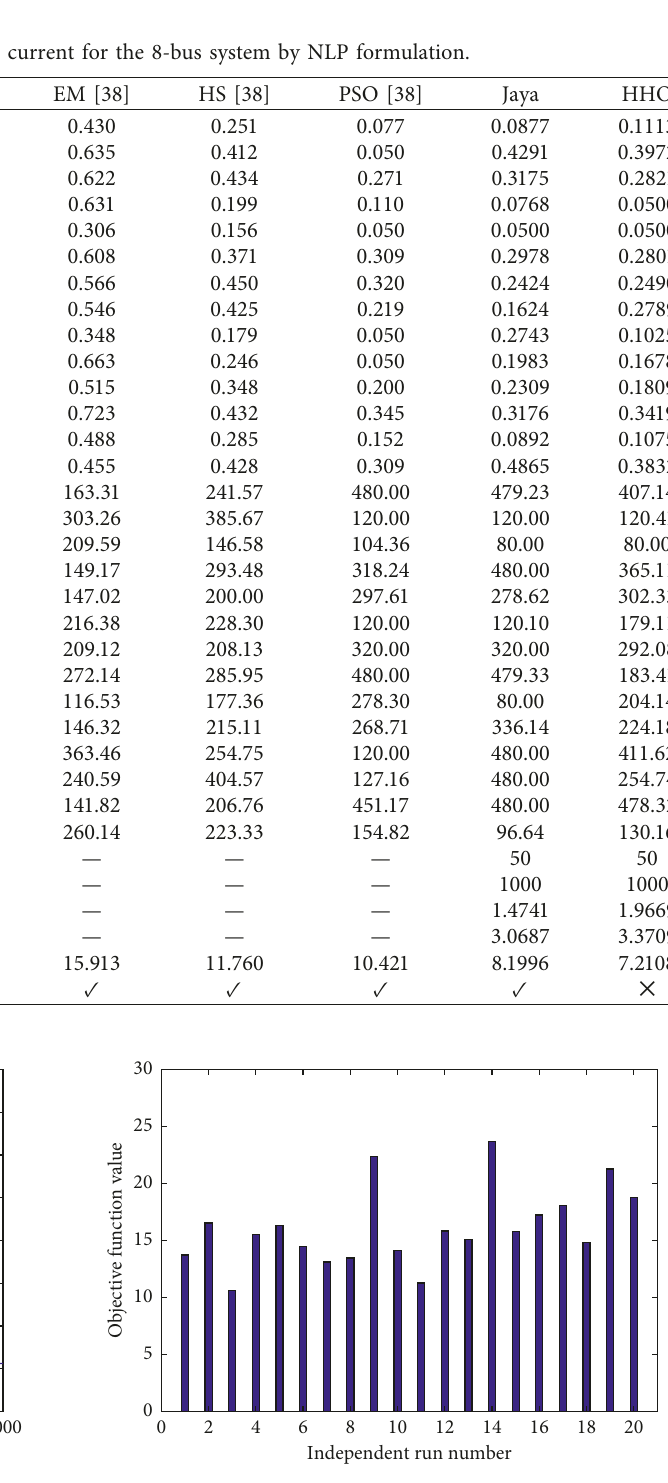
Figure 10: Independent runs for the 8-bus system by NLP